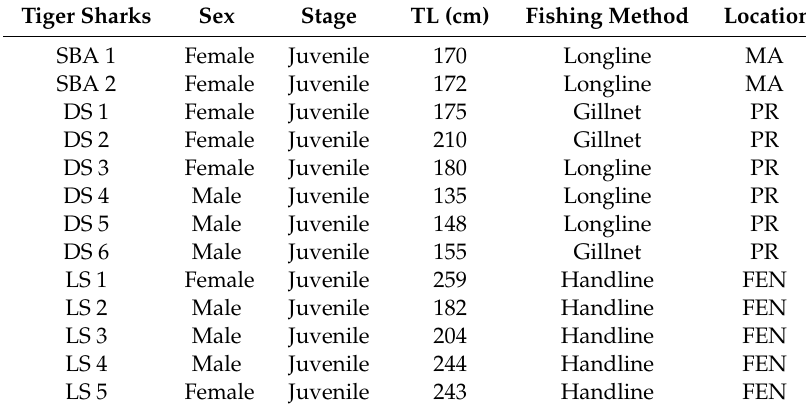
Table 1. Tiger sharks analyzed in the present study. Sex, life stage and total length (TL), fishing method, and fishing location are presented for each shark. SBA—sharks with bile accumulation, DS—dead sharks, LS—live